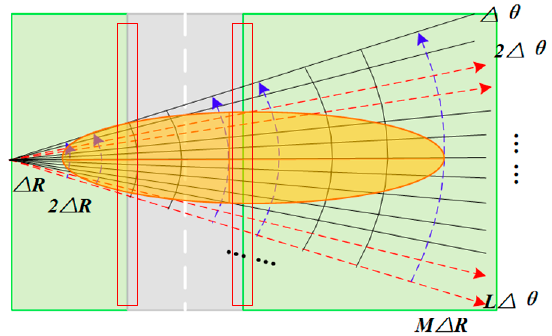
Figure 2. Dividing the scene into resolution cells in polar system.